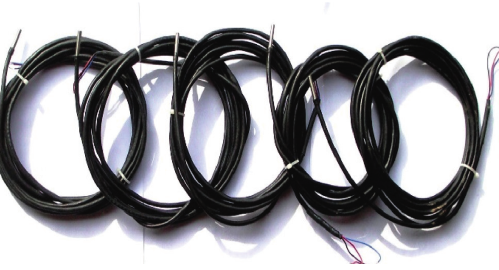
Figure 3: JMT-36X temperature sensors assemblies.